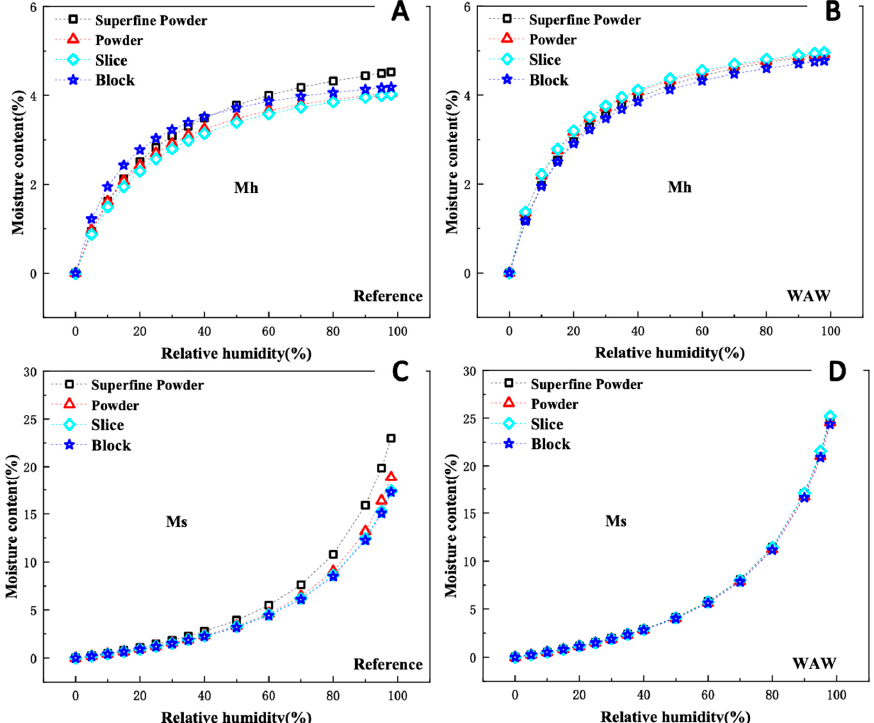
Figure 4. M h of reference samples ( A ) and WAW samples ( B ) in adsorption process. M s of reference samples ( C ) and WAW samples ( D ) in adsorption process.